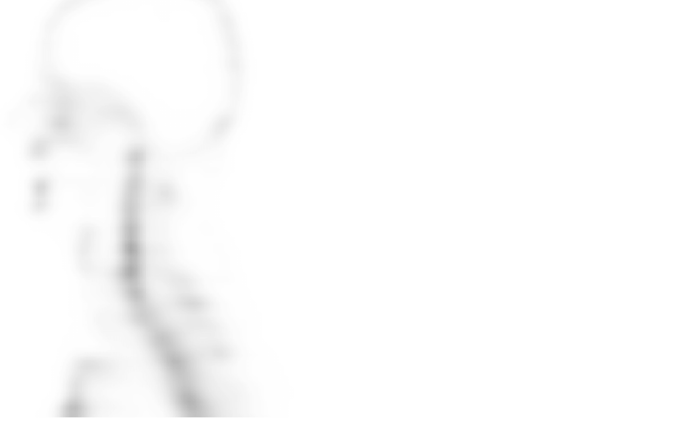
Figure 2: (SPECT) : Sagittal SPECT bone scan does not demonstrate any abnormal focal uptake within the cervical or thoracic spine.